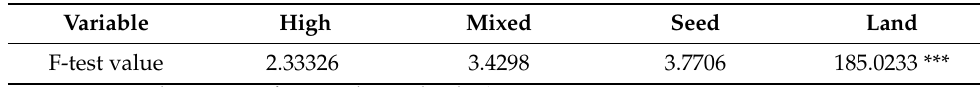
Table 9. Results of F-test under significant level α = 0.01.